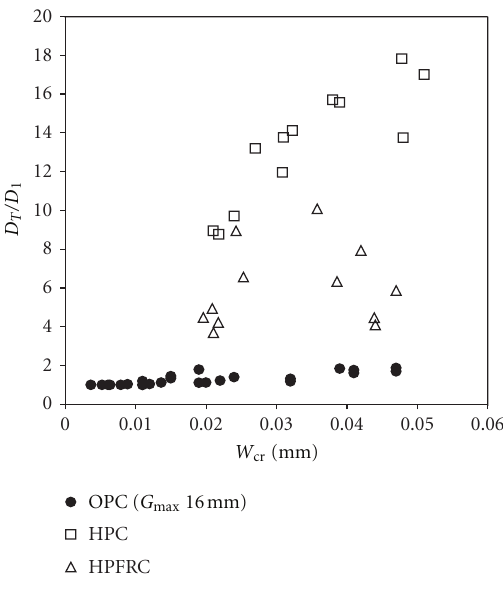
Figure 7: Relative di ff usivity versus concrete type.